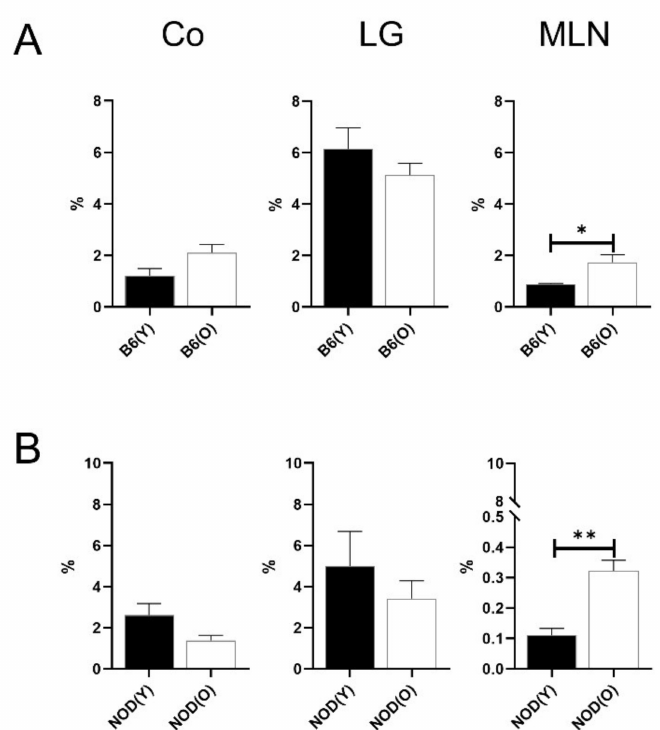
Figure 5. Distribution of CD103 + CD11b + DCs in B6 ( A ) ( n = 4) and NOD.B10.H2 b ( B ) mice ( n = 4). The total number of CD45 + cells was used as the denominator to compensate for the actual fraction of each subset in corneolimbus and LG. In MLN, the percentage of subsets was calculated as the percentage within total cells. The percentage of MLN CD103 + CD11b + DCs were significantly increased in both mouse models ( p = 0.025 in B6, p = 0.002 in NOD.B10.H2 b , respectively). All experiment results were tested for statistical differences using unpaired, two-tailed independent t-tests. Data are expressed as the mean ± standard error of the mean. B6, C57BL/6; NOD, NOD.B10.H2 b ; DC, dendritic